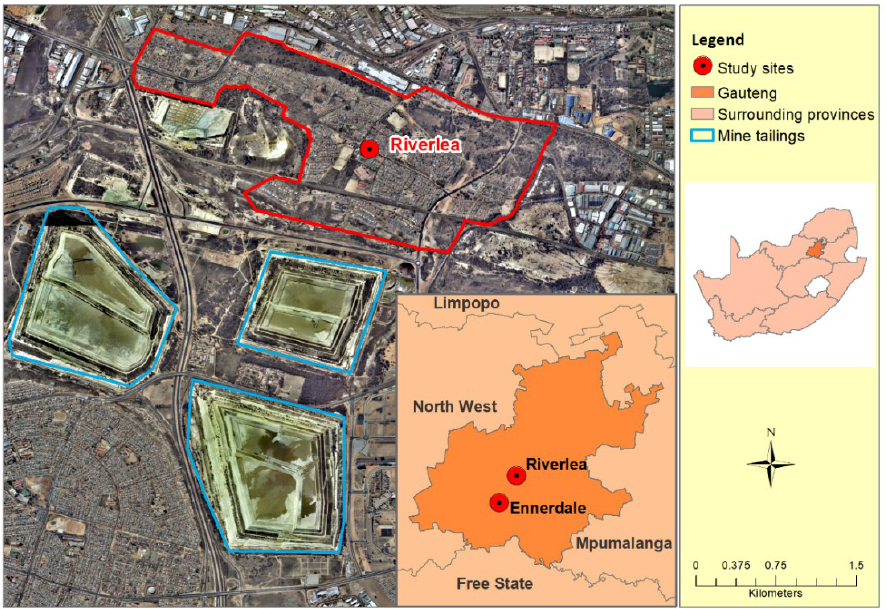
Figure 1. Map of the study area showing the study sites and proximity to gold mine tailings.